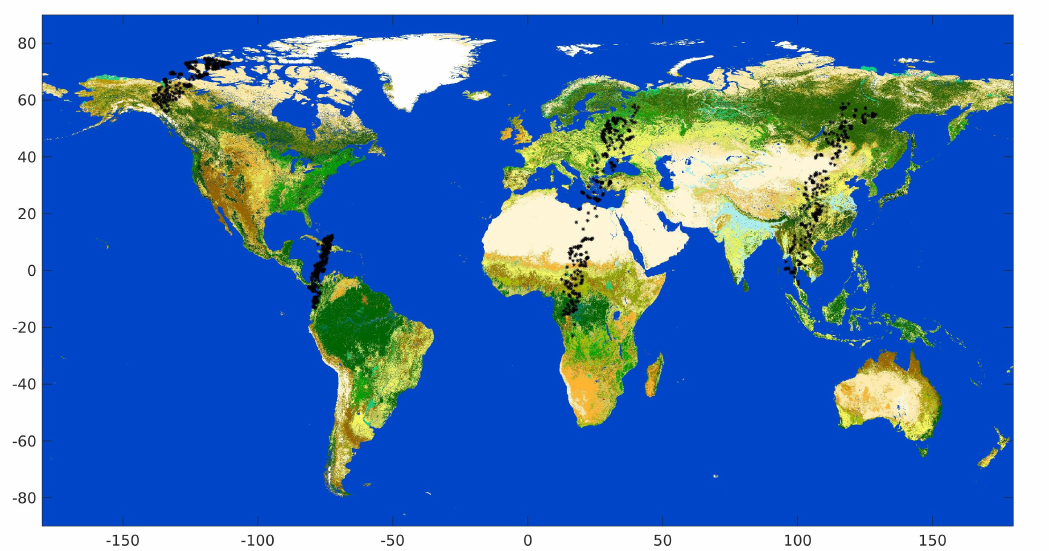
Figure 1. Global surface map as provided by GlobCover (22 classes). The superimposed black dots represent the pixels belonging to the gold standard dataset in the PROBA-V Round Robin